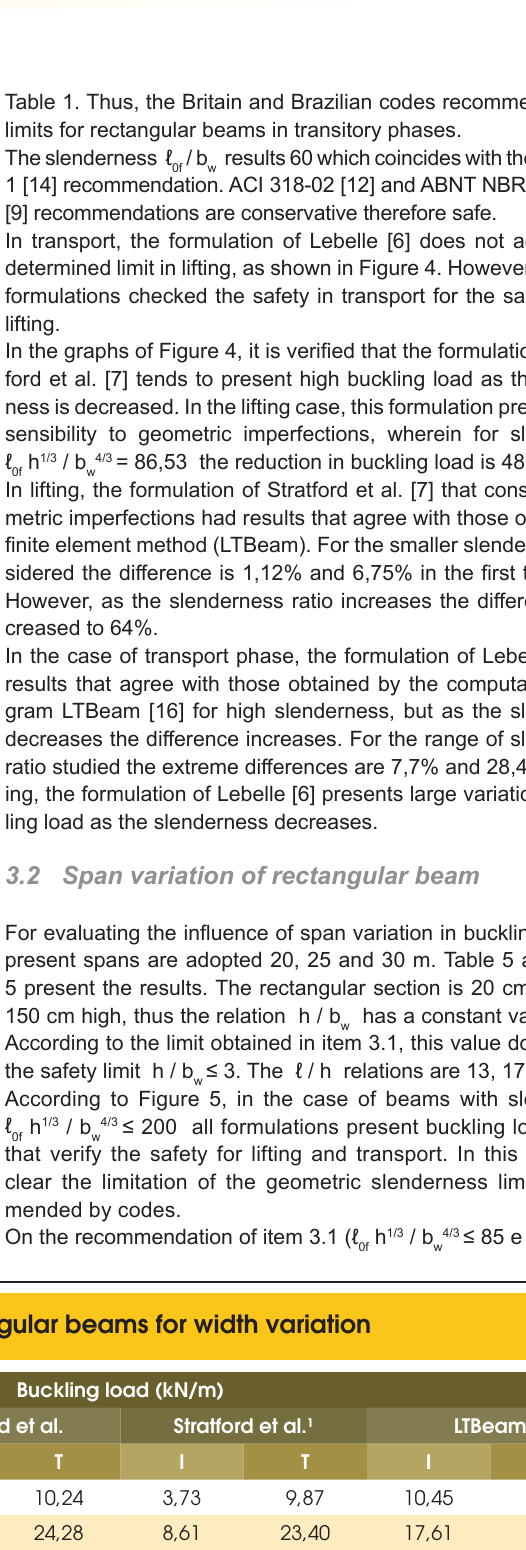
utilized sections for parametric analysis